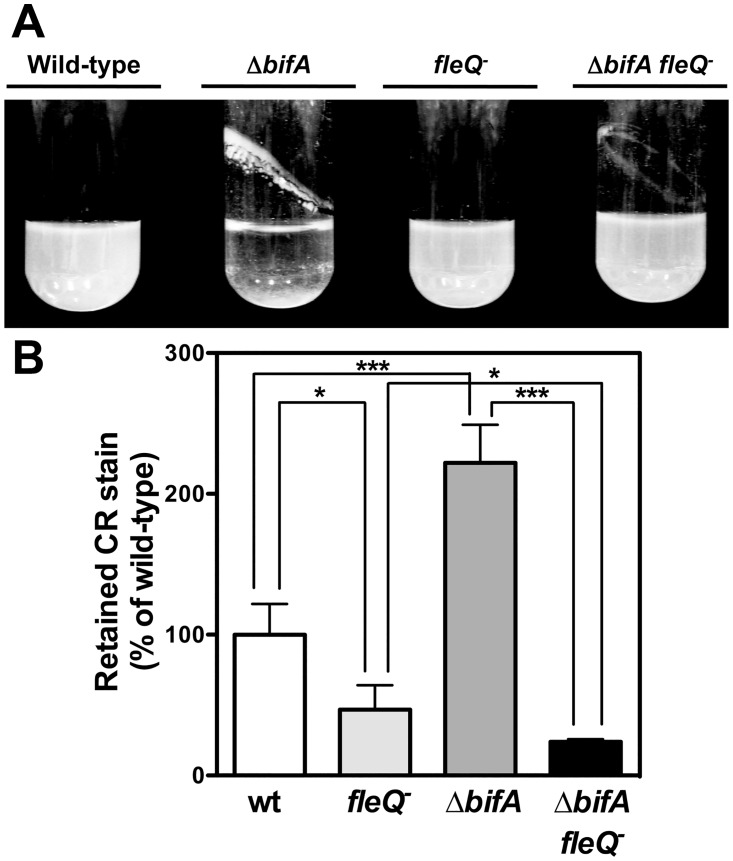
Pellicle, aggregation and CR adsorption phenotypes of ΔbifA and fleQ mutants.A. Photographs of planktonic cultures of the wild-type (KT2442), ΔbifA (MRB32), fleQ (MRB35) and ΔbifA fleQ (MRB50) strains showing pellicle formation and culture clarification due to aggregation. B. CR adsorption of the wild-type (KT2442), ΔbifA (MRB32), fleQ (MRB35) and ΔbifA fleQ (MRB50) strains. Data are normalized to the wild-type, set to 100%. Bars represent the averages and standard deviations of at least three independent assays.